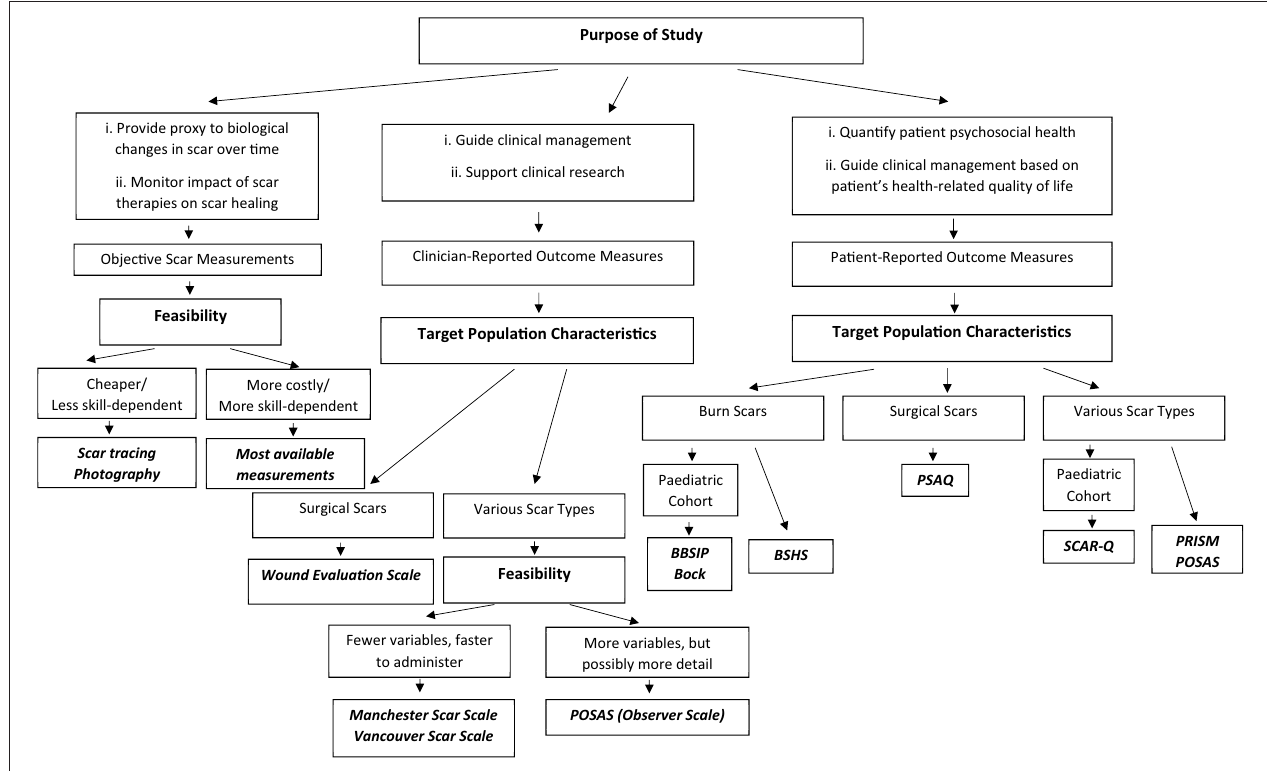
FIGURE 1 | A proposed guide to how to use currently available scar assessment tools.